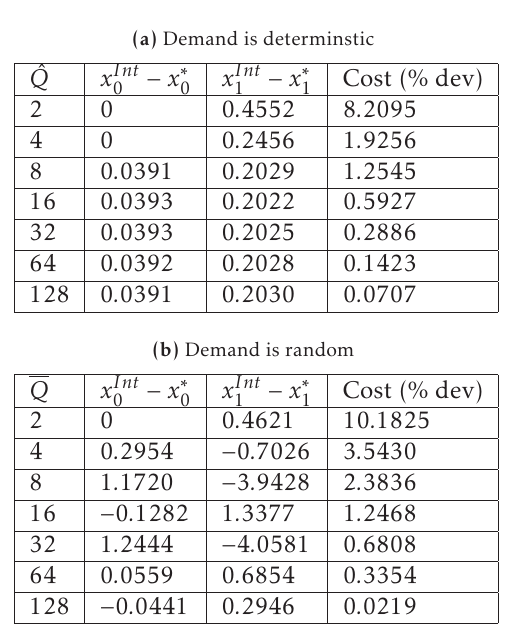
Table 3. SPO under DSR constraint and discrete